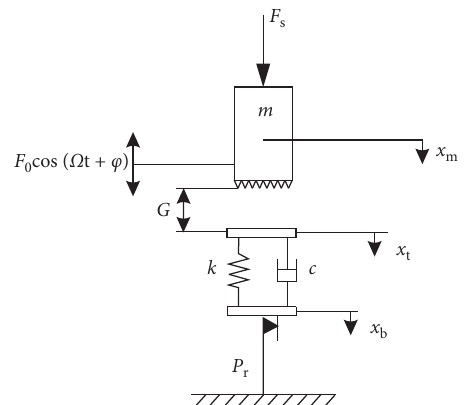
Figure 1: Simplified rock-breaking model between drill bit and